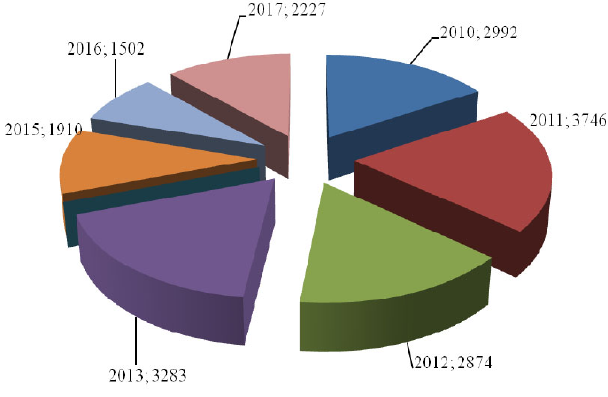
Fig. 4. Total fishing in the Mykolaiv region.